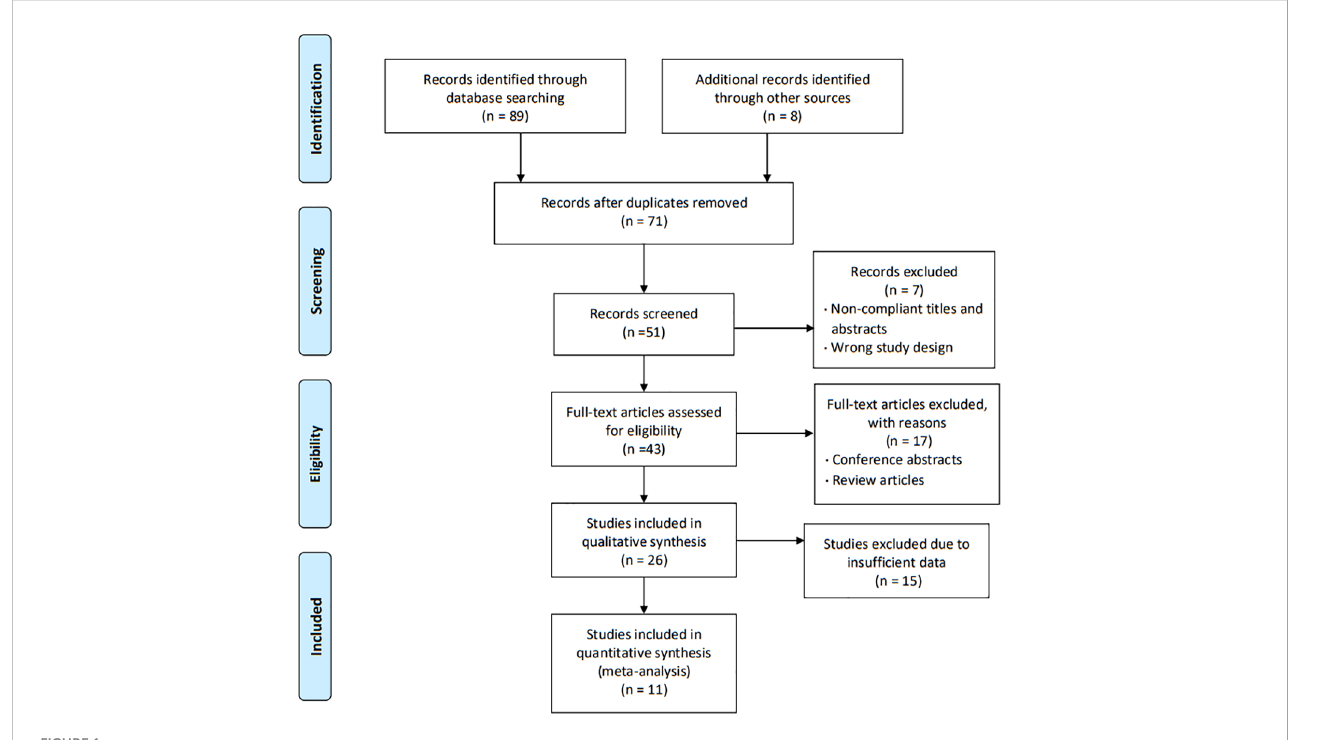
FIGURE 1 Study selection